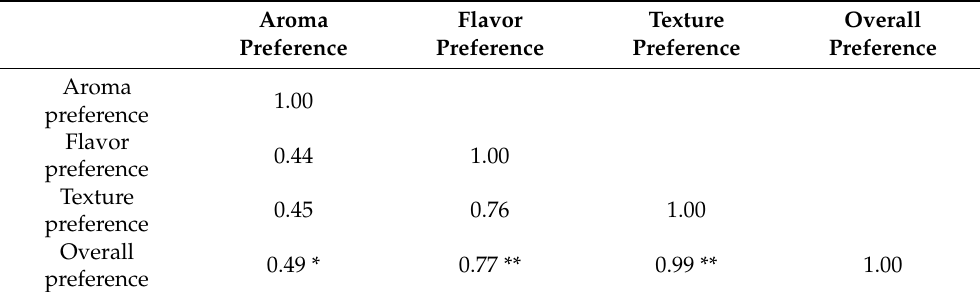
Table 4. The Pearson correlation analysis of sensory evaluation